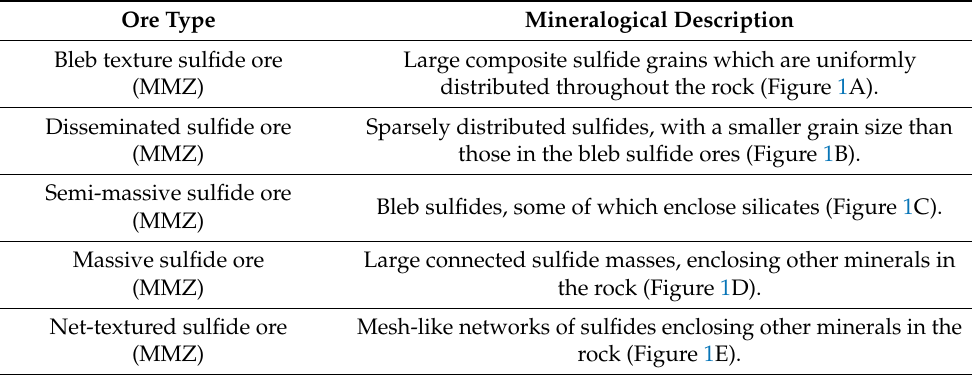
Figure 1. Macroscopic images of the distribution of sulfides (i.e., rock textures) of hand-sized polished rock slabs of ore samples collected from the MMZ ( A – E ), as well as the PCMZ ( F , G ) ore horizons. Scale bar bottom right = 1 cm. Table 1. Macroscopic textures of ore types from the MMZ AND PCMZ ore horizons.